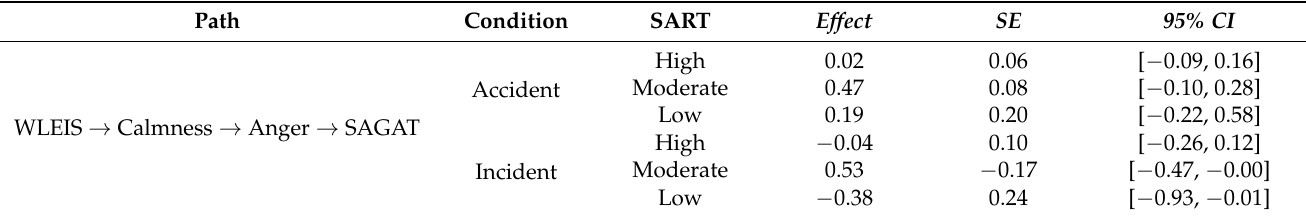
Table 4. Parameter estimates of conditional process